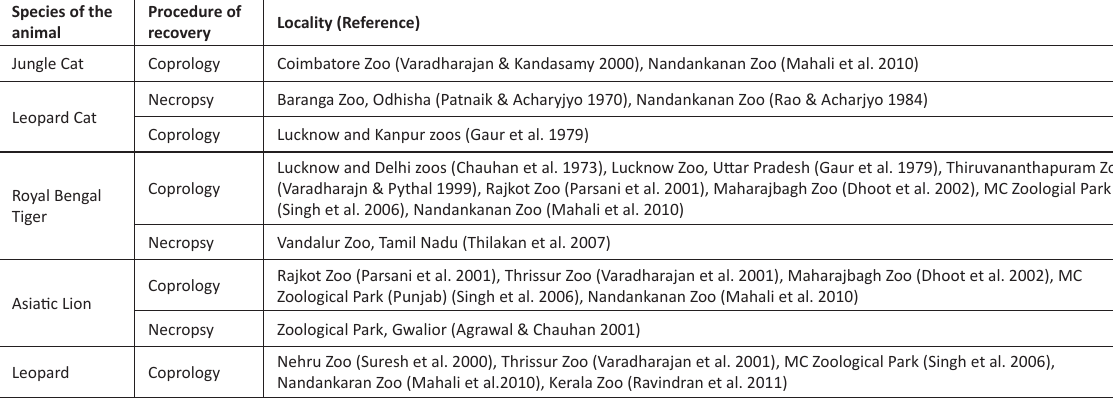
Table 3. Reports of hookworms from wild felids of different parts of India Species of the